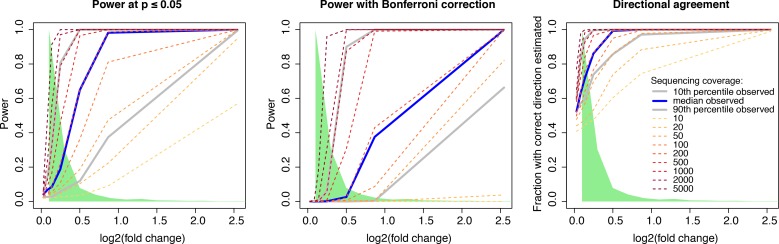
Power to detect allele-specific expression.The figure shows the results from a simulation study that varied the strength of true ASE (x-axis) and the depth of sequencing coverage, expressed as the number of reads covering the two alleles of the gene. Different depths of coverage are shown as colored lines. The blue line indicates the median coverage per gene observed in (Albert et al., 2014a), and the grey lines indicate the 10th and 90th coverage quantile in the same reference. The green area indicates the fold-changes observed for local eQTLs to show the ASE magnitudes that may be expected in real data. On the y-axes, the panels show: Left: Power to detect ASE at nominal significance of p≤0.05, Middle: Power to detect ASE with Bonferroni correction across the number of expressed genes, Right: the fraction of simulated ASE datasets in which the observed direction of ASE matched the true direction, irrespective of statistical significance.